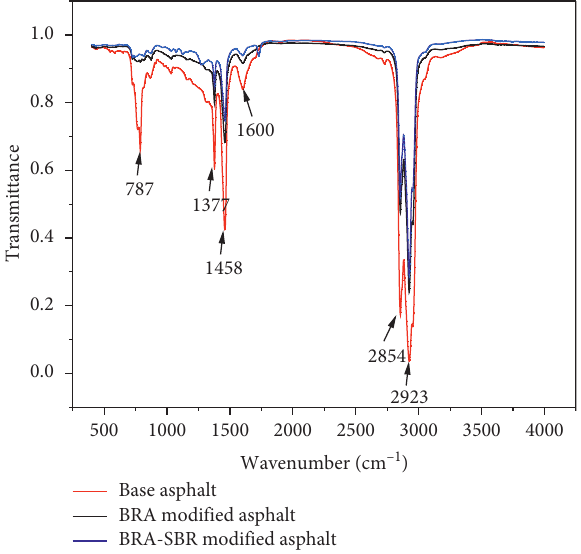
Figure 3: Infrared spectra of three types of